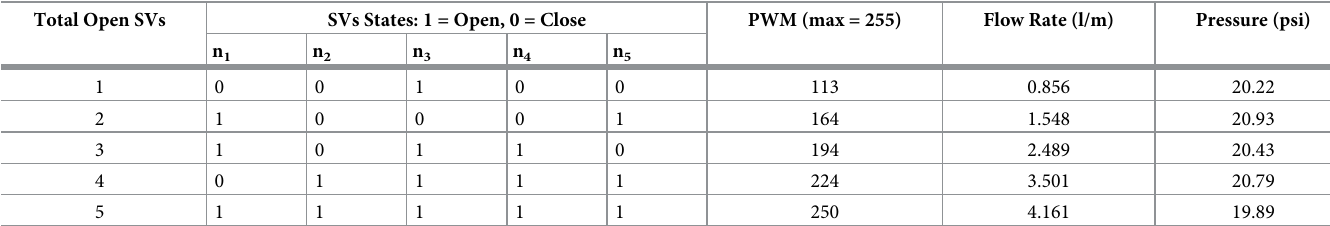
Table 4. Pressure-flow response for open